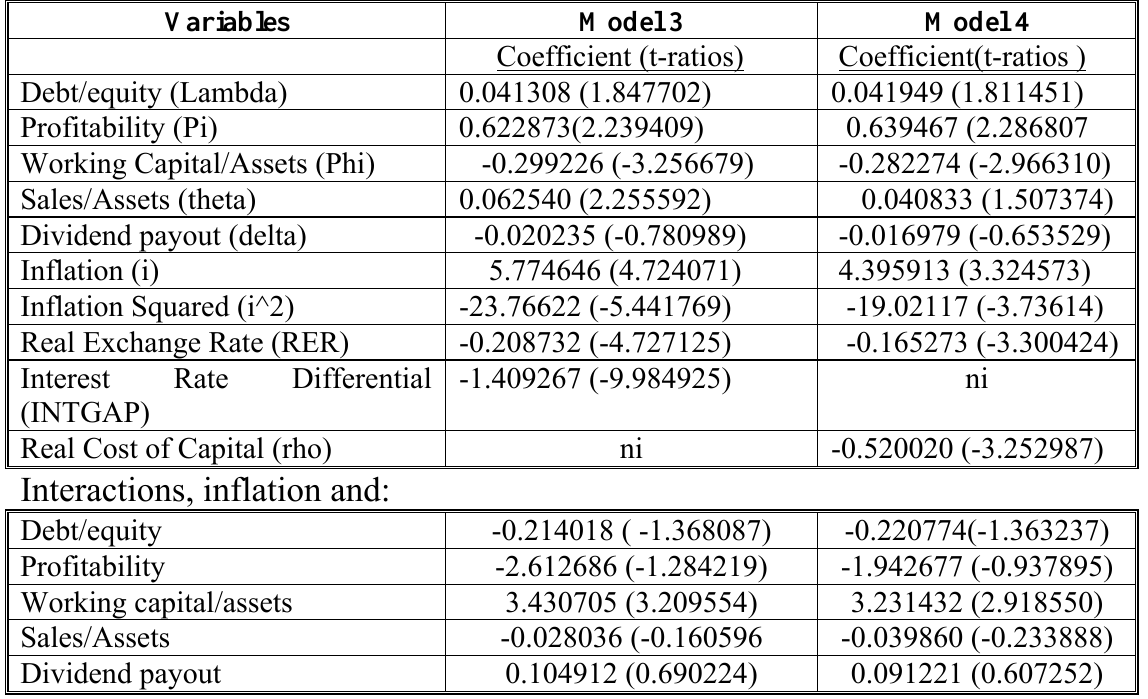
Inflation, financial ratios and firms growth: Estimation